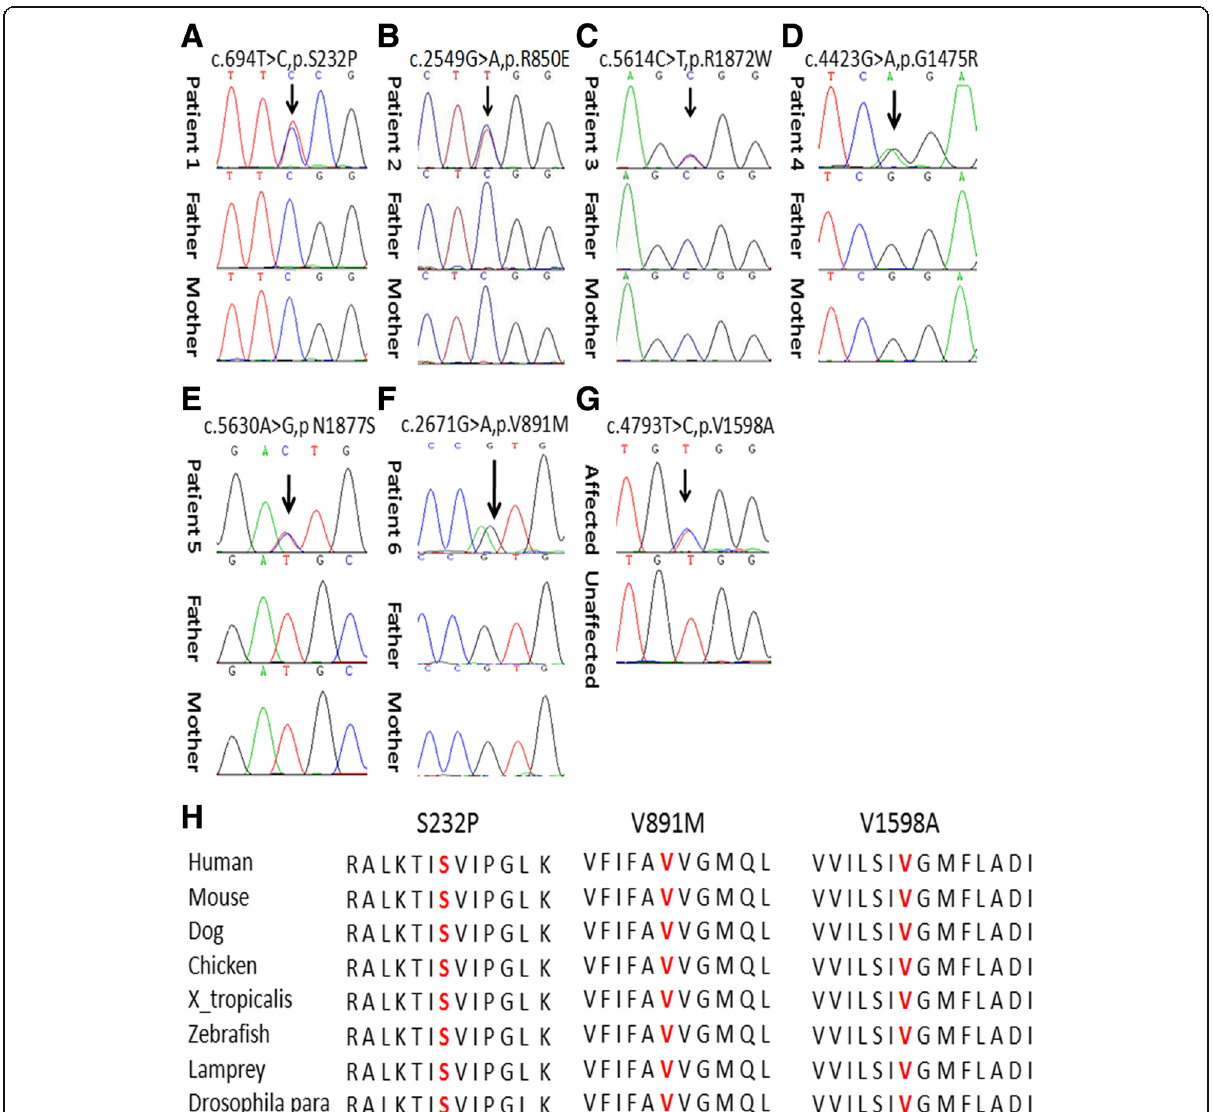
Fig. 2 Seven SCN8A mutations identified in this study a - g and conservation of the altered amino acid of three unreported mutations shown in the ClustalW alignments h